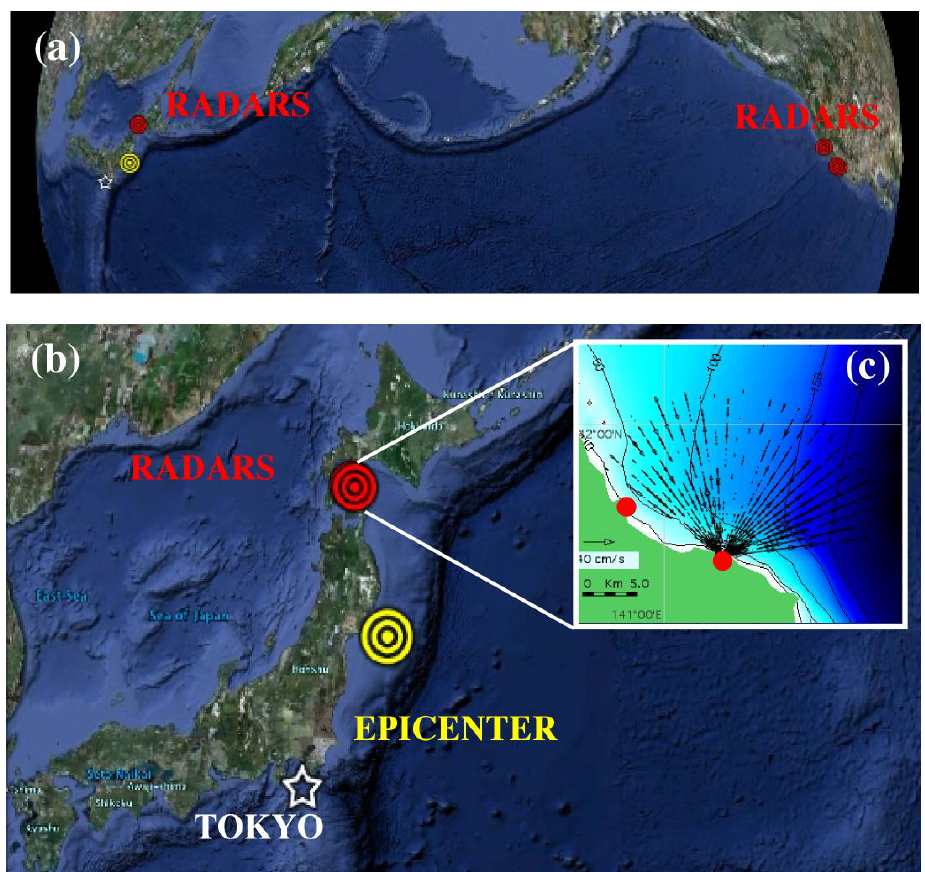
Figure 1. (a) The North Pacific Ocean showing the location of the radars in Japan and California that provided data for this paper; (b) The location of the Japan earthquake and the radars in Hokkaido; (c) The bathymetry offshore from the radars and radial velocities measured by the Kinaoshi radar, 11 March 2011, 21:00